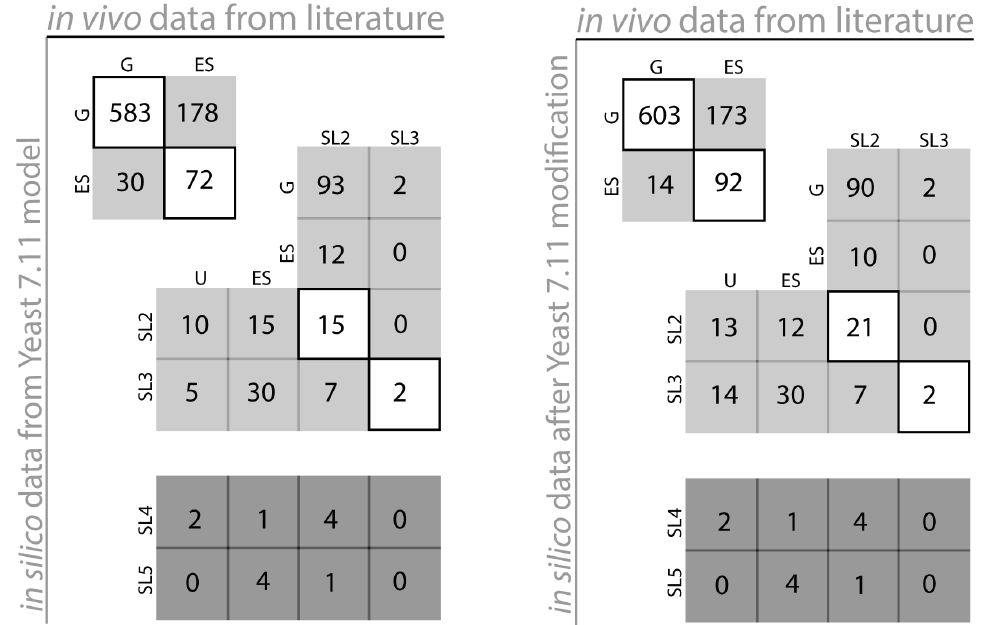
Figure 1. Yeast 7.11 model performance comparison (Yeast 7.11: left, i Sce926: right). The diagonal boxes represent points of in silico-in vivo match. The non-diagonal elements represent points of in silico in vivo inconsistency